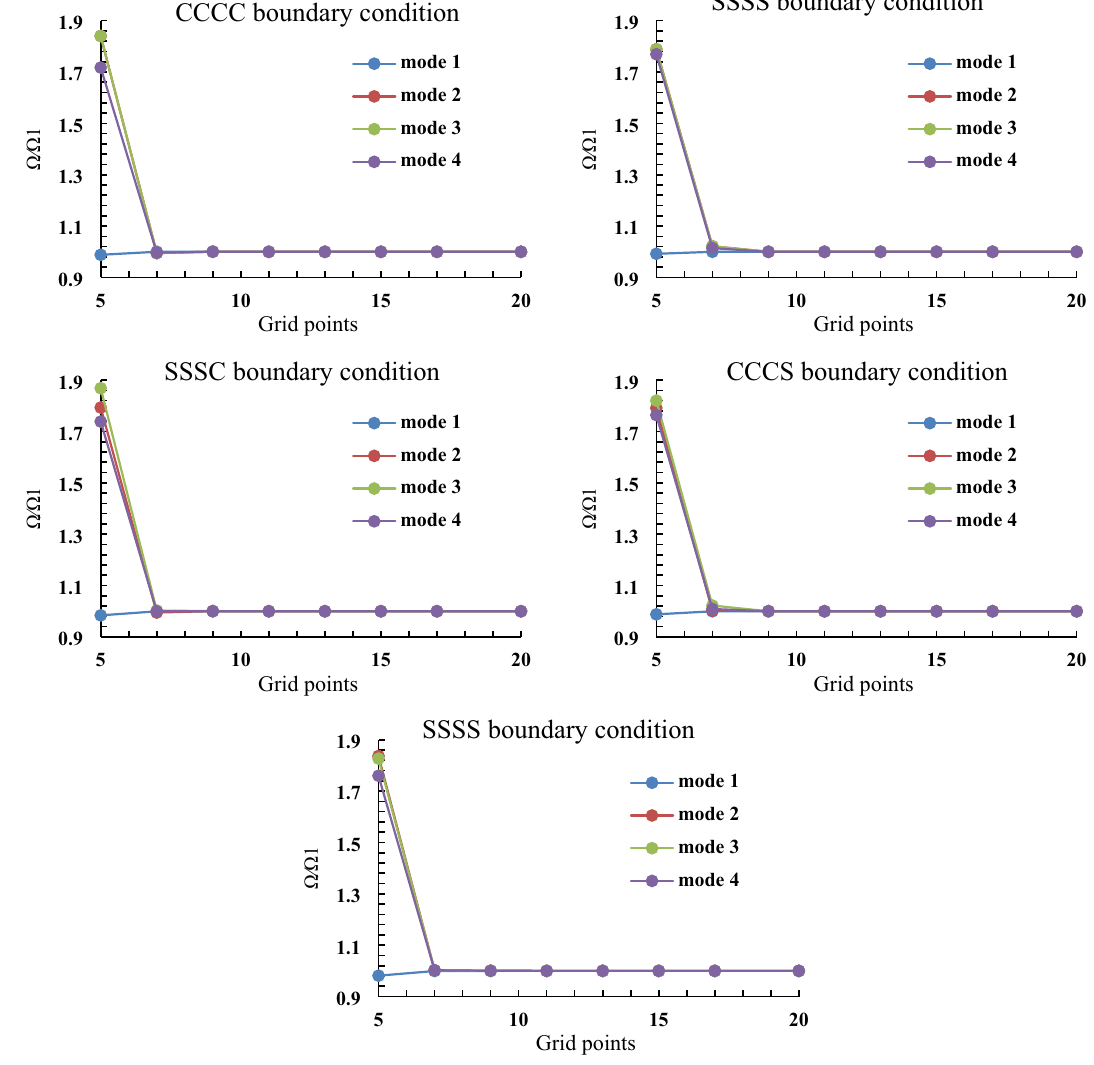
Fig. 6 convergence study of present model for different boundary